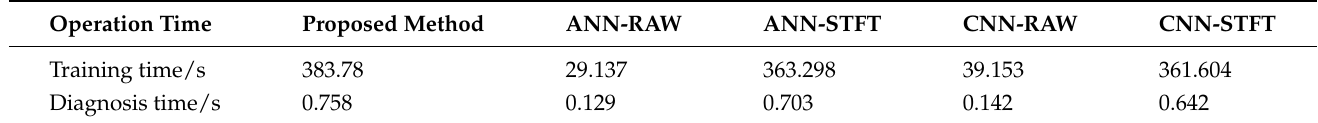
Table 6. The efficiency of proposed and contrasting